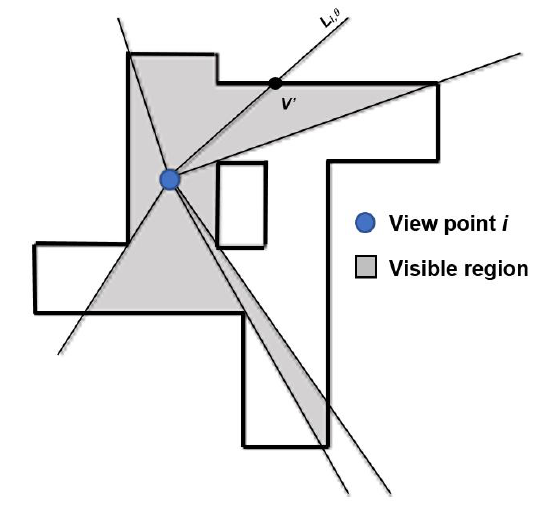
Figure 5. Visible region from the viewpoint i.